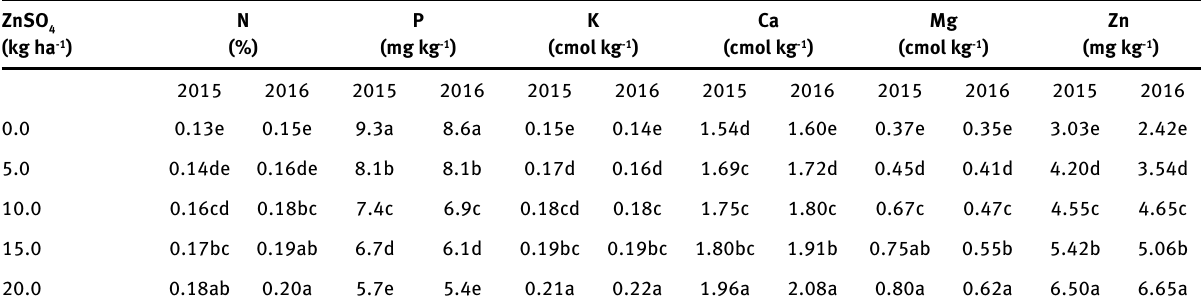
fertilizer on soil chemical properties 4